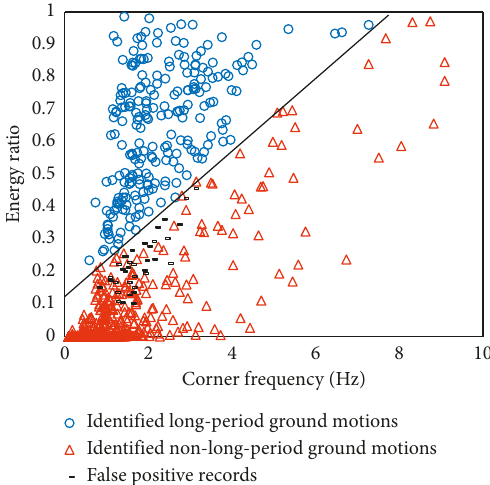
Figure 6: Scatter plots of predictive variables of corner frequency and energy ratio for the classifications. Note that the representation of the false positive is manually classified as a long-period record but is identified as a non-long-period record by using the proposed method; the black line signifies the boundary to demarcate two discrete